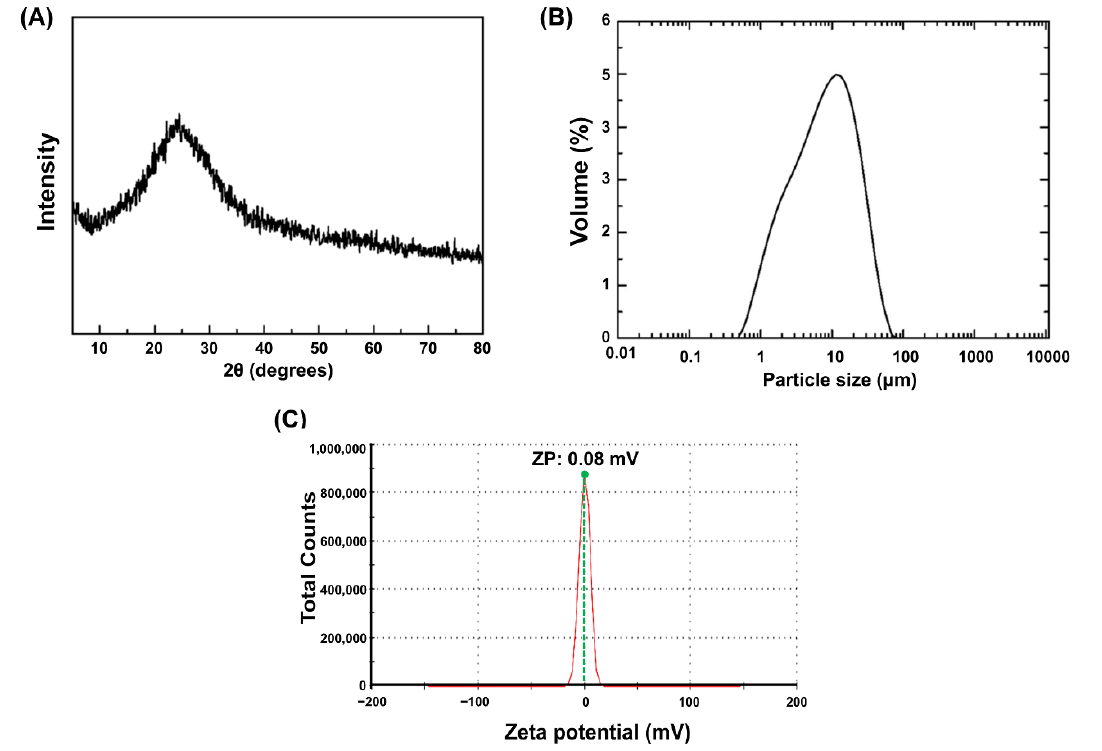
Figure 1. Particulate properties of silver-phosphate glass: ( A ) X-ray diffraction patterns of silver- phosphate glass, ( B ) particle size distribution, ( C ) zeta potential distribution.